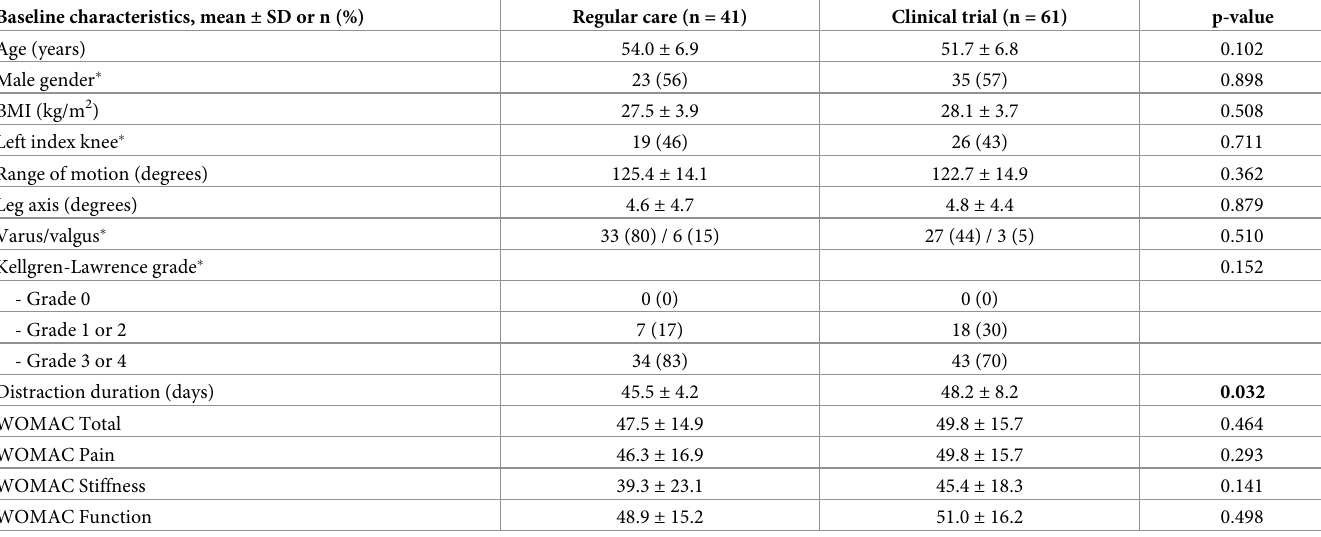
Table 3. Baseline characteristics of patients treated with knee joint distraction in regular care and in clinical trials, who completed both WOMAC baseline and 12-month follow-up